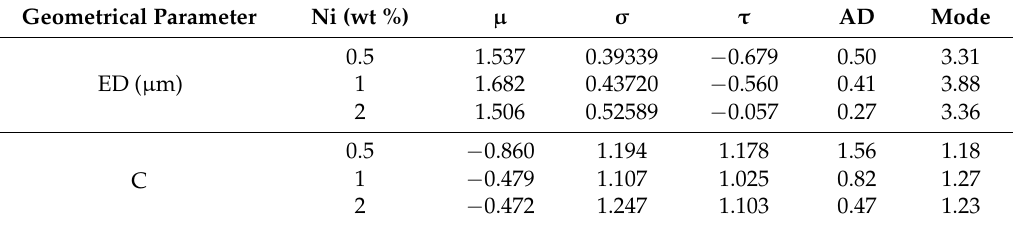
Table 2. Lognormal parameters for ED and C of Si eutectic particles in the investigated alloys, after T6 heat